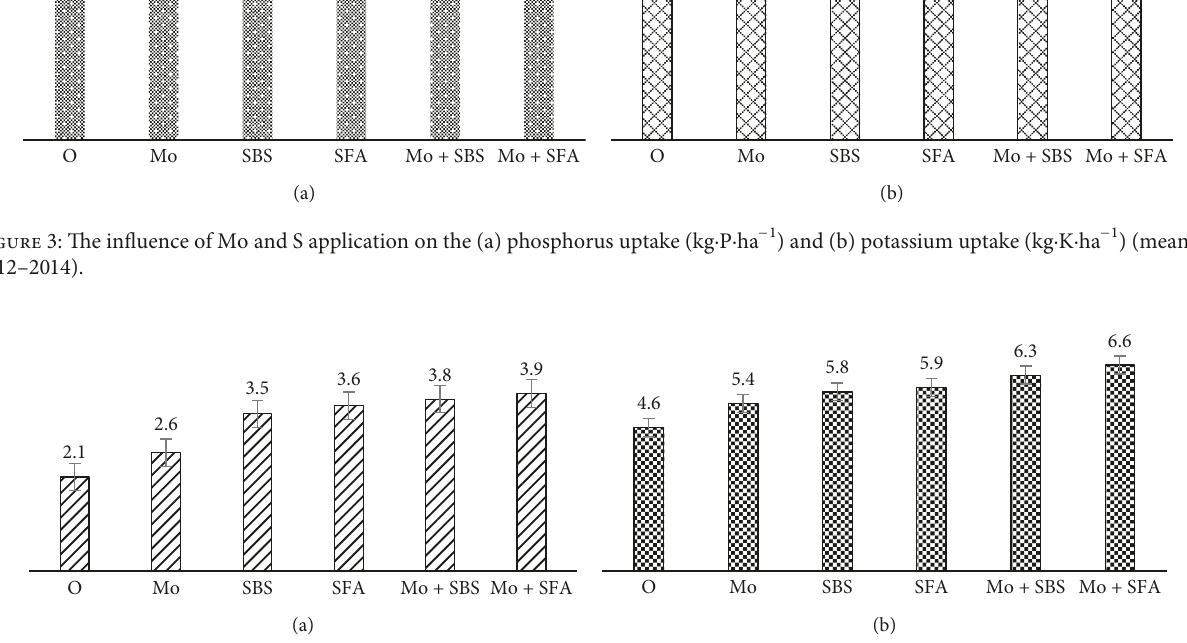
Figure 4: The influence of Mo and S application on the (a) calcium uptake (kg · Ca · ha − 1 ) and (b) magnesium uptake (kg · Mg · ha − 1 ) (mean for